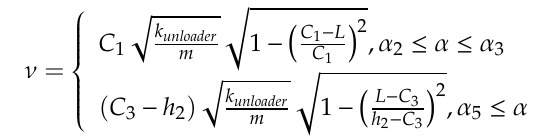
Table 4. Increase amplitude of cylinder pressure in different backflow clearance. Gap Value(mm)